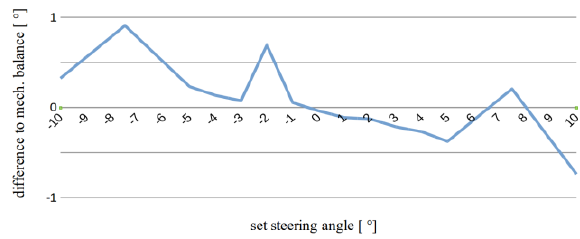
Figure 8. Differences of determined steering angles related to the mechanical balance using 3D shape-based matching